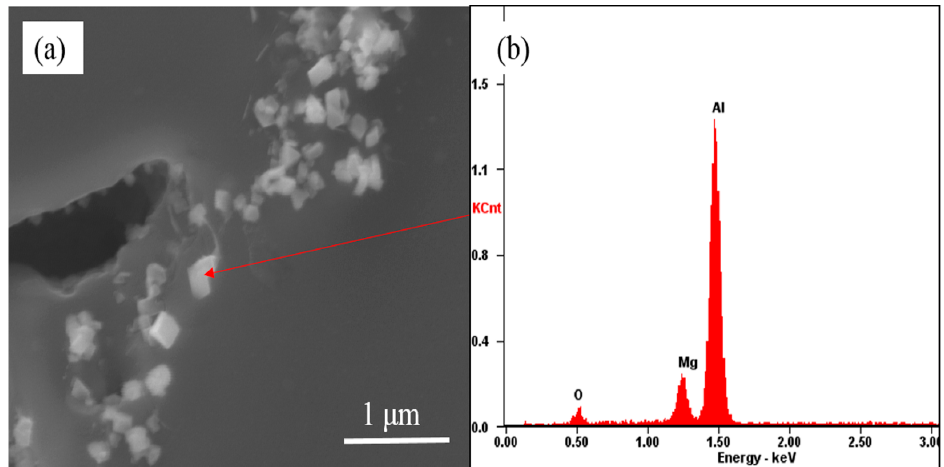
Figure 6. ( a ) The micro-morphology of A356 alloy scraps after being held in the commercial pure aluminum melt for 30 min; ( b ) Corresponding EDS results.